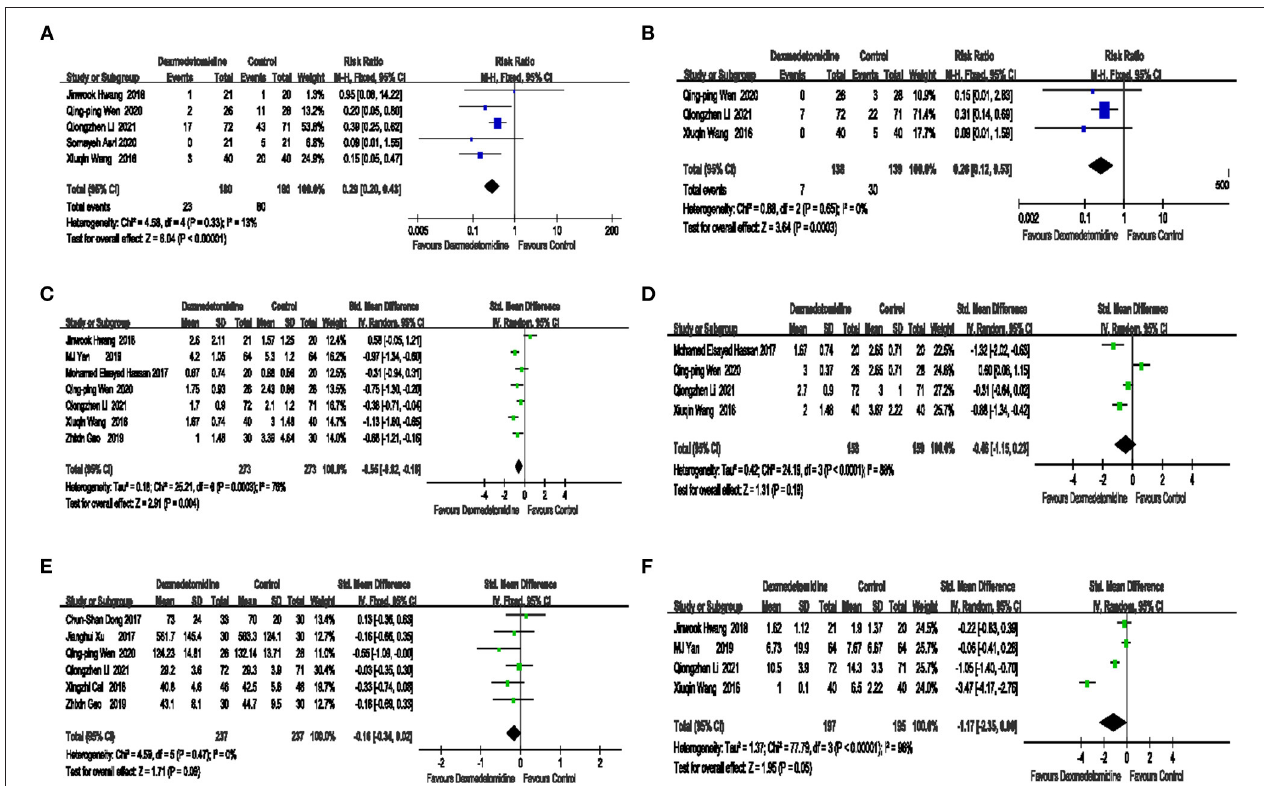
FIGURE 4 | The effect of dexmedetomidine on postoperative nausea, vomiting, and pain control. Compared with placebo, dexmedetomidine significantly reduced the incidence of postoperative nausea (A) . The risk of postoperative vomiting in the dexmedetomidine group was significantly lower than that in the control group (B) . Compared with placebo, dexmedetomidine significantly reduced the postoperative visual analog score (VAS) score at rest (C) . No significant difference in the postoperative VAS score for coughing was noted between dexmedetomidine and placebo (D) . No significant difference in the amount of intraoperative sufentanil was noted between dexmedetomidine and placebo (E) . The number of postoperative salvage angles in procedures significantly differed between dexmedetomidine and placebo (F)